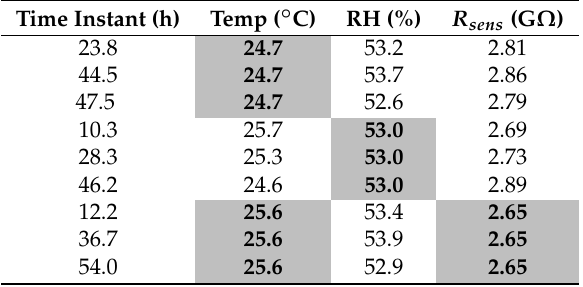
Table 3. Temperature, relative humidity (RH) and wood resistance values for specific time instants in steady-state measurements. The same values for a measure are marked in